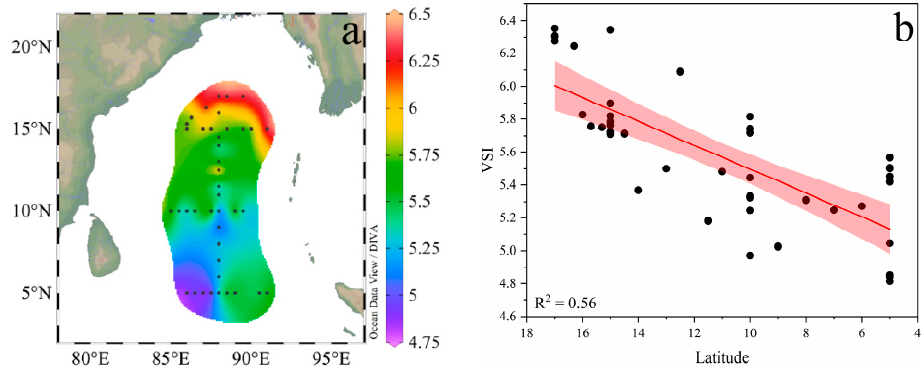
Figure 3. Distribution of the vertical stratification index (VSI). ( a ) Horizontal distribution of the vertical stratification index (VSI). ( b ) Linear fits of the vertical stratification index (VSI) with latitude.